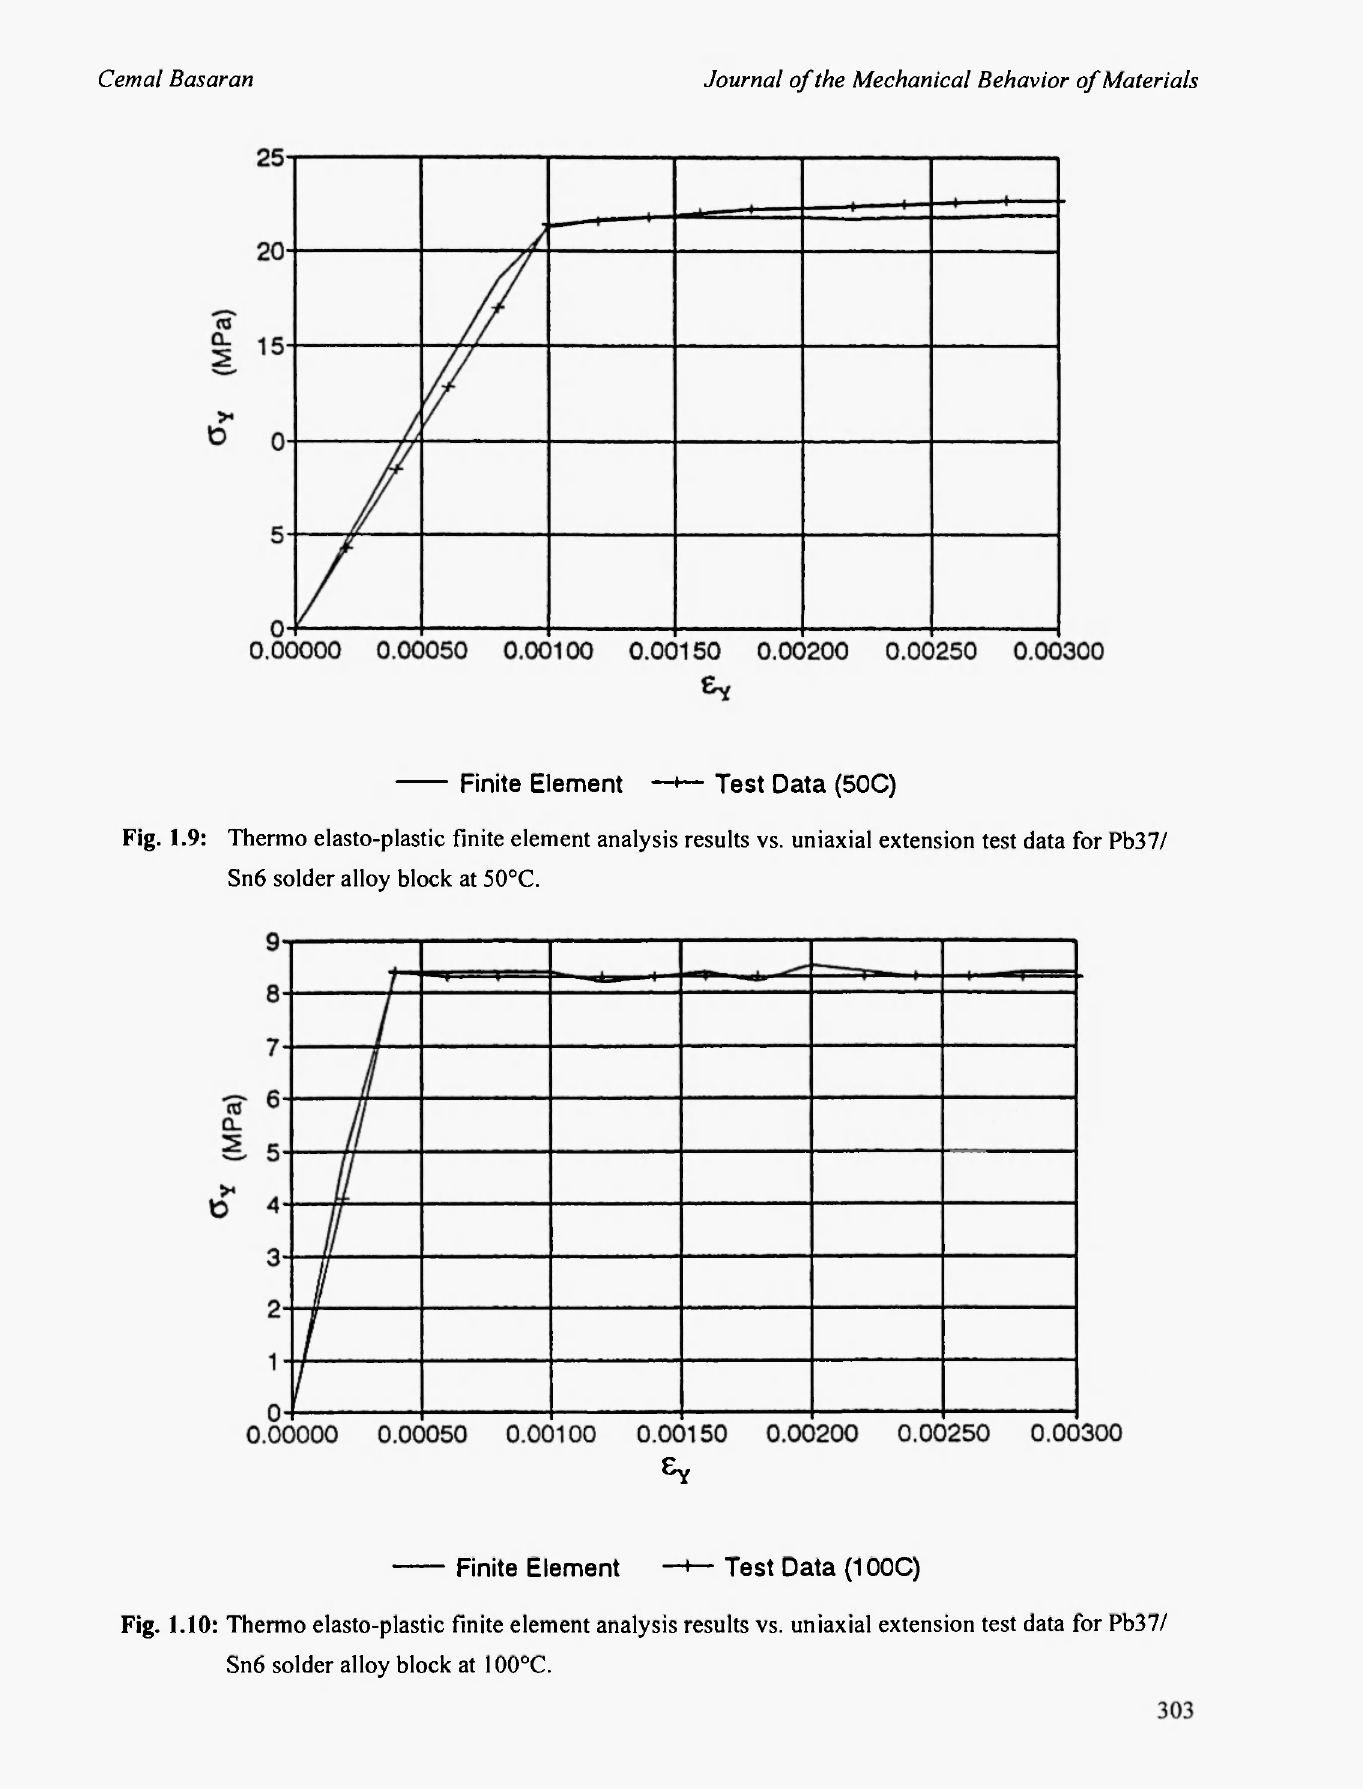
Fig. 1.10: Thermo elasto-plastic finite element analysis results vs. uniaxial extension test data for Pb37/ Sn6 solder alloy block at